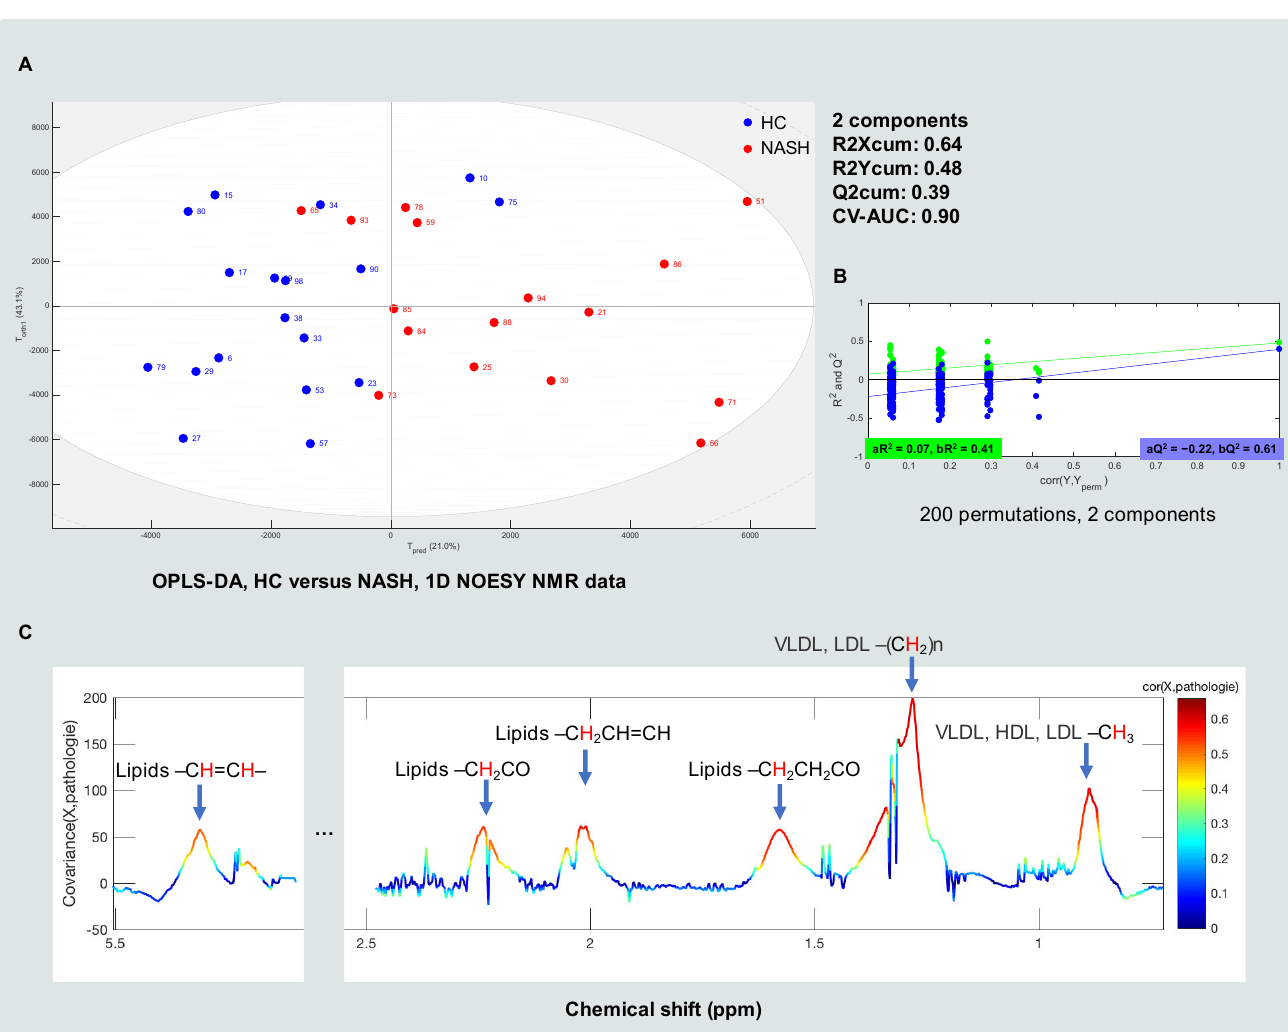
Figure 2. The NMR ‐ based plasma metabolomics of MAFLD: ( A ) the OPLS ‐ DA score plot (HC versus NASH; 1D NOESY data); ( B ) the 200 times permutation test for the OPLS ‐ DA model (HC versus NASH; 1D NOESY data); ( C ) the OPLS ‐ DA covariance plot (HC versus NASH; 1D NOESY data). The red hydrogen atom indicates the 1 H detected by 1 H NMR.